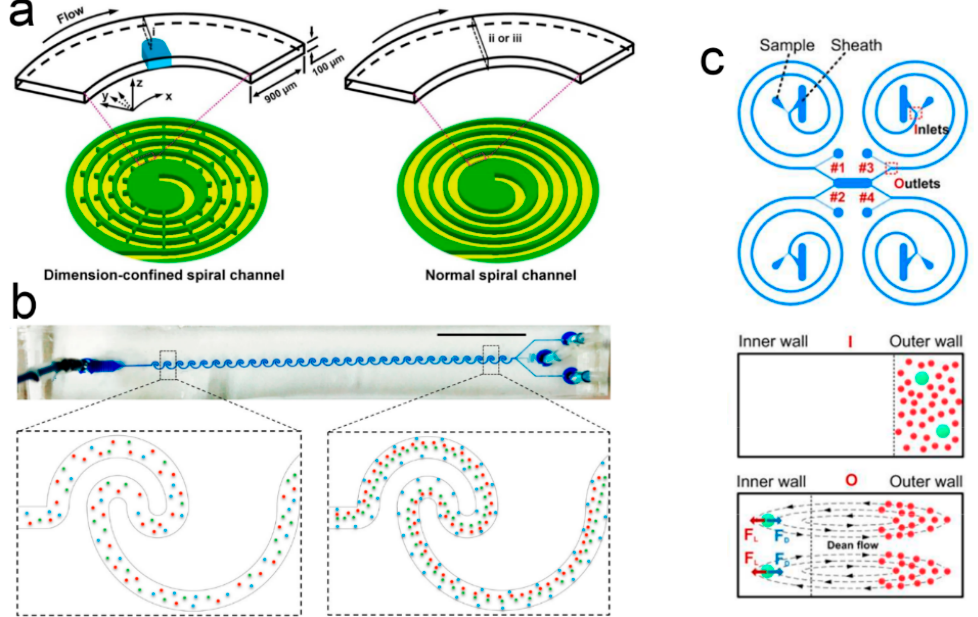
Figure 16. ( a ) Principal scheme of the device employing Dean-like secondary flow acceleration induced by micro-bars in the spiral microchannel. Reprinted with permission from [304]. Copyright 2017, The Royal Society of Chemistry. ( b ) Asymmetric reverse wavy microchannel inducing periodically reversible Dean flow. Reprinted with permission from [306]. Copyright 2018, Springer Nature. ( c ) Design of the separation device employing Dean flow with multiple separation areas. Reprinted with permission from [309]. Copyright 2001, The Royal Society of Chemistry.